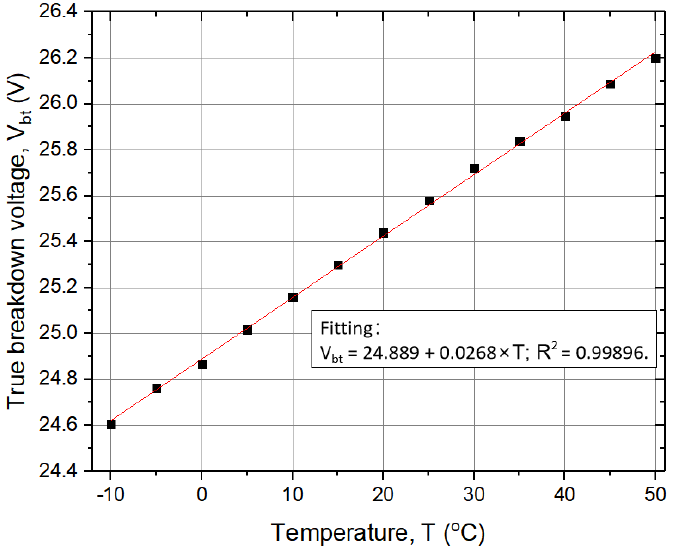
Figure 6. Linear fitting for the true breakdown voltages on the SPAD versus temperatures.